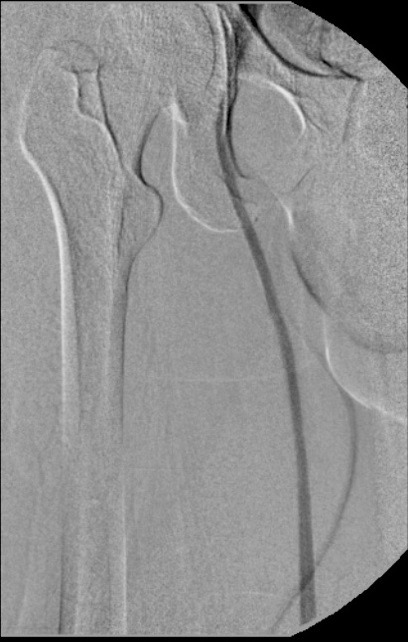
Ascending phlebography showing great saphenous vein and common femoral vein. The femoral vein was not observed in this segment.